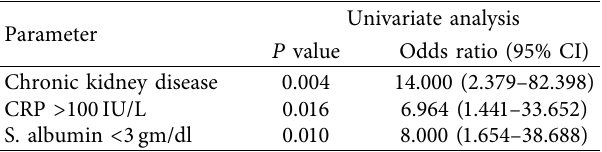
Table 3: Univariate analysis of mortality risk factors in melioidosis.